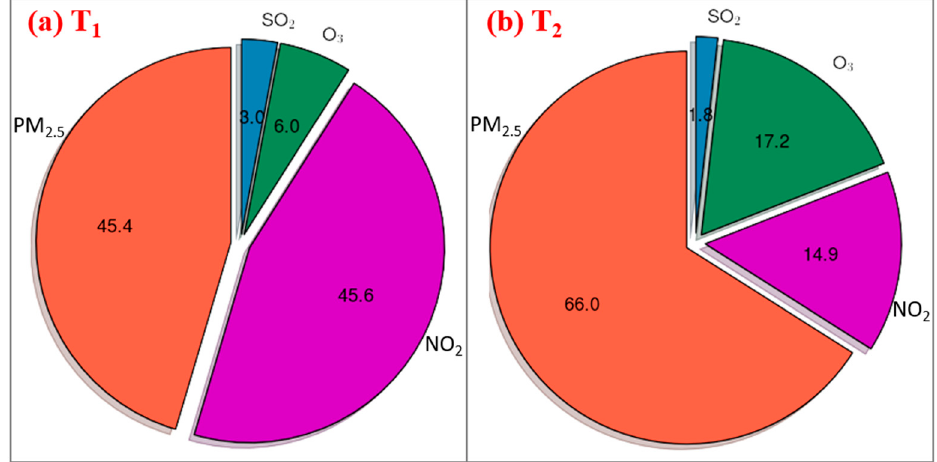
Figure 8. Fractions of the %AR of mortality for the four air pollutants at two pollution peaks: ( a ) T 1 and ( b ) T 2 . Results were obtained using the 𝛽 coefficients of the global review.